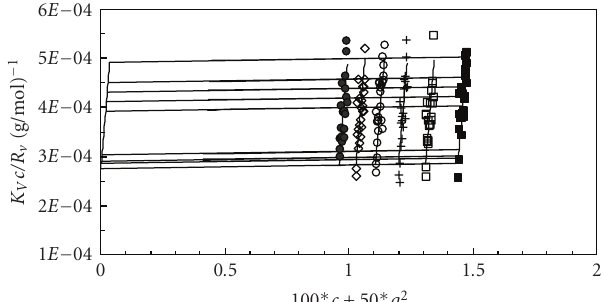
Figure 3: Zimm analysis by a two-power law linear regression (full line) which yields to the molecular size for molecule 1 from both extrapolations to q , c → 0. M W = 3620 dalton and (cid:3) R 2 57nmA 2 = 3 . 5 10 − 4 molml / g2 ( (cid:2) ) = 1.44 10 − 2 g/ml; ( (cid:3) ) =